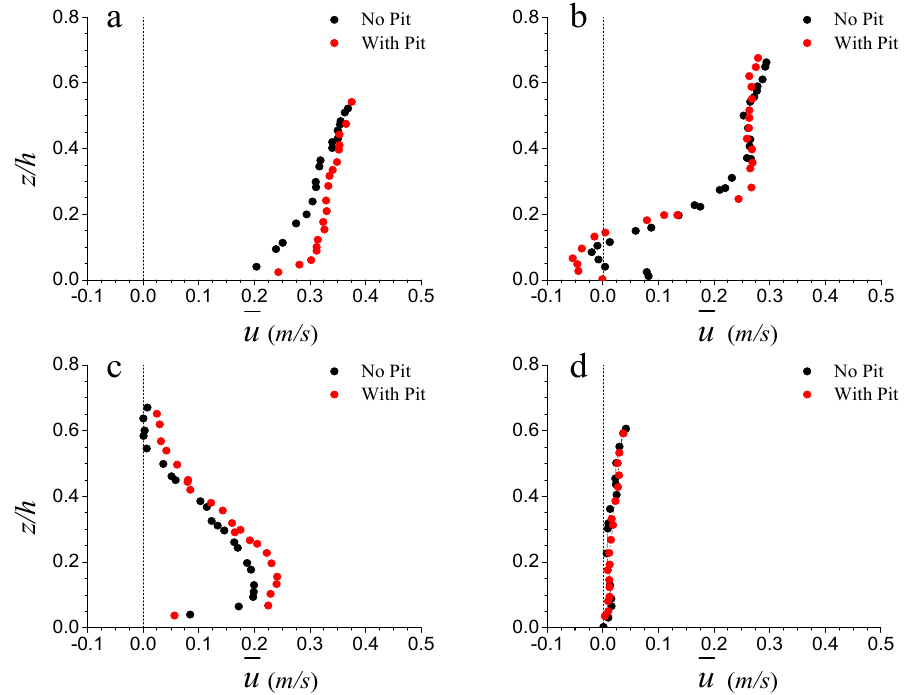
Figure 4. Streamwise mean velocity profiles at: ( a ) Location 1, ( b ) Location 2, ( c ) Location 3, and ( d ) Location 4.